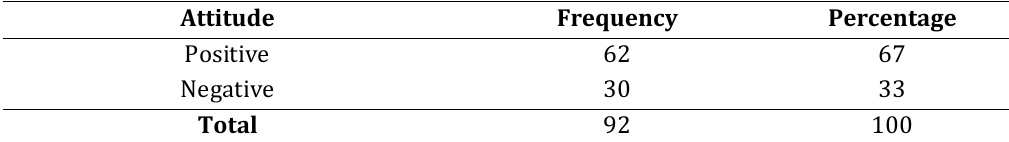
Distribution of frequency and percentage of attitudes to prevent increased uric acid